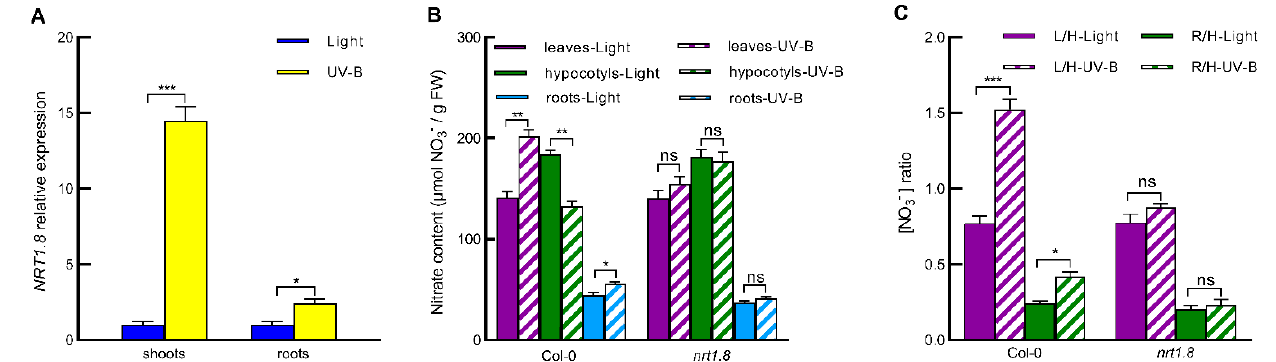
Figure 2. UV-B induced NRT1.8 expression and NRT1.8 mediated UV-B-induced nitrate reallocation to leaves and roots. ( A ) NRT1.8 expression was determined by qPCR in shoots and roots of wild-type Col-0 exposed to light alone (Light) or with 0.5 W/m 2 UV-B (UV-B) for 3 h. Data are presented as values relative to those of shoots and roots under light treatments after normalization to those of ACTIN2 . ( B ) Nitrate content was determined in leaves, hypocotyls and roots of wild-type Col-0 and nrt1.8 plants exposed to light alone (Light) or with UV-B (UV-B) for 3 h. ( C ) Leaf/hypocotyl (L/H) and root/hypocotyl (R/H) nitrate ratios were calculated after determination of nitrate levels. Values are means ± SE ( n = 3). Asterisks indicate significant differences between light and UV-B treatments (* p < 0.05; ** p < 0.01; *** p < 0.005; ns: no significant difference).